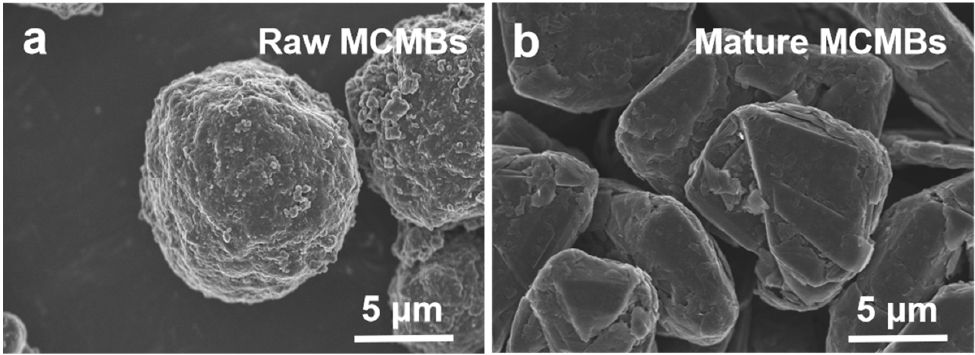
Figure 1. Morphology of MCMBs: ( a ) raw MCMBs; ( b ) mature MCMBs.